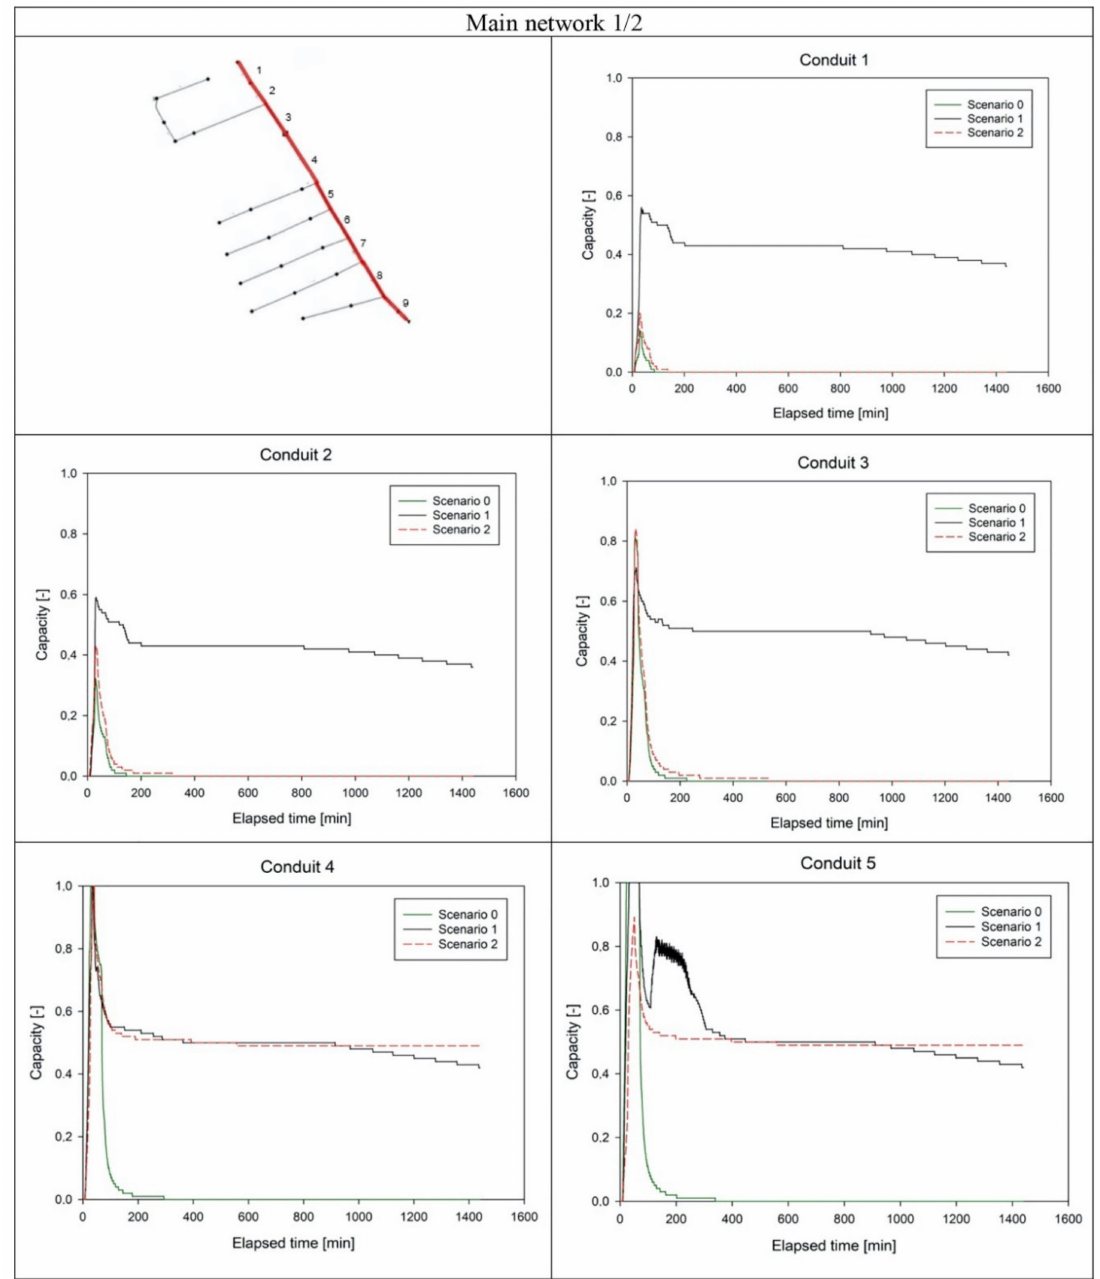
Figure A1. Conduits’ capacity in the main network, highlighted in red in the first picture where the drainage network schematization is